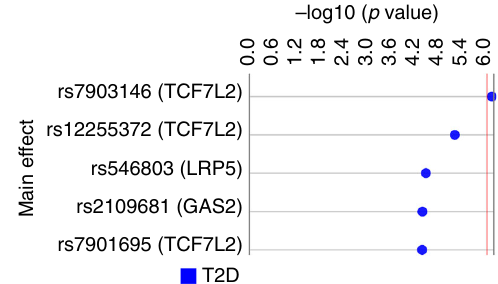
Fig. 2 Five main effect results with uncorrected p value < 0.0001. Main effect analysis was performed for 33,683 SNPs and 3374 samples (835 cases, 2539 controls) using logistic regression in PLATO. This Synthesis View 58 plot denotes the SNP (nearest gene) on the left and the track to the right displays the – log10 of the uncorrected main effect p value. The red line denotes the Bonferroni threshold for corrected signi fi cance (uncorrected p : 1.48 × 10 − 6 ; α = 0.05, 33,683